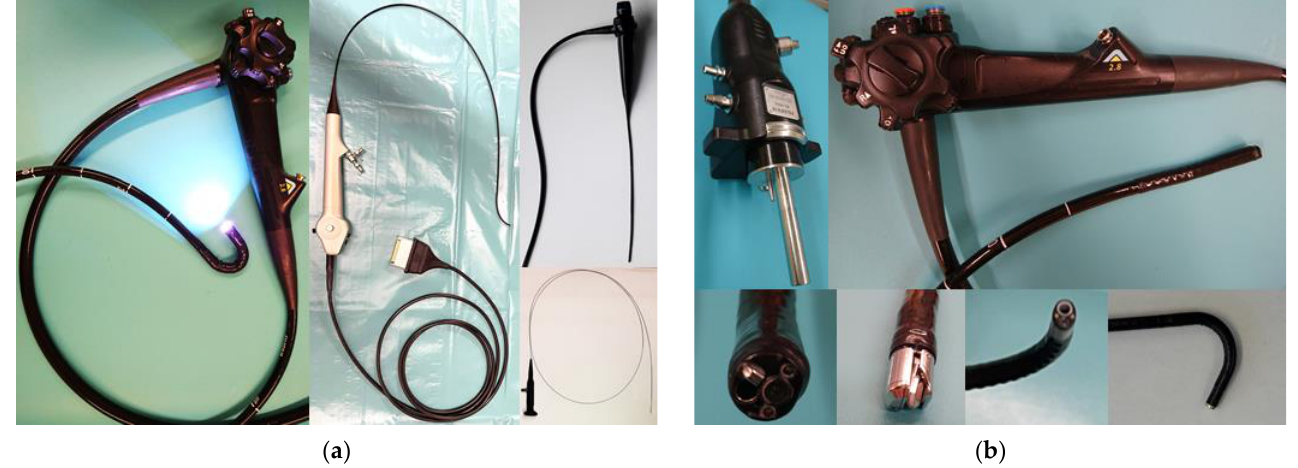
Figure 3. ( a ) Variants of flexible endoscopes: Fujifilm gastroscope, KARL STORZ cystoscope, OLYMPUS rhinolaryngoscope, flexible fiber endoscope ( b ) Flexible video endoscope components, upper row: Fujifilm connector plug to the imaging system, Fujifilm gastroscope handle, lower row: Fujifilm